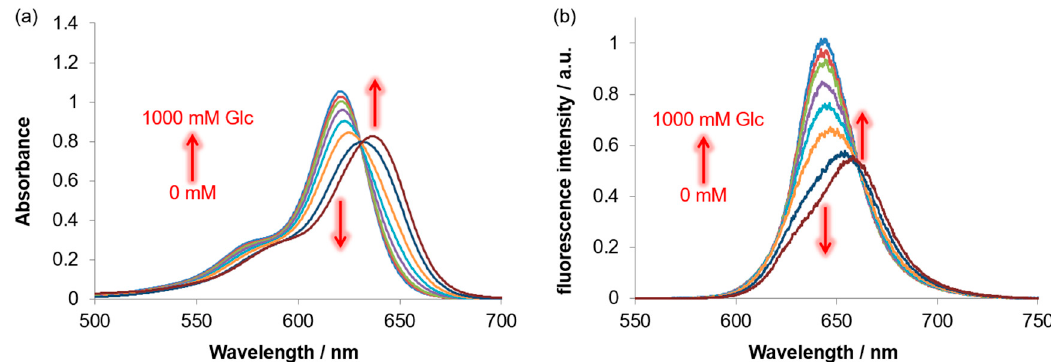
Figure 6. Effect of different concentrations of Glc (0, 10, 20, 50, 100, 200, 500, and 1000 mM) on the ( a ) absorption spectra, and ( b ) fluorescence spectra (excited at 621 nm) of BRhoC (8.5 μ M) in a 10 mM HEPES buffer at pH 7.4.